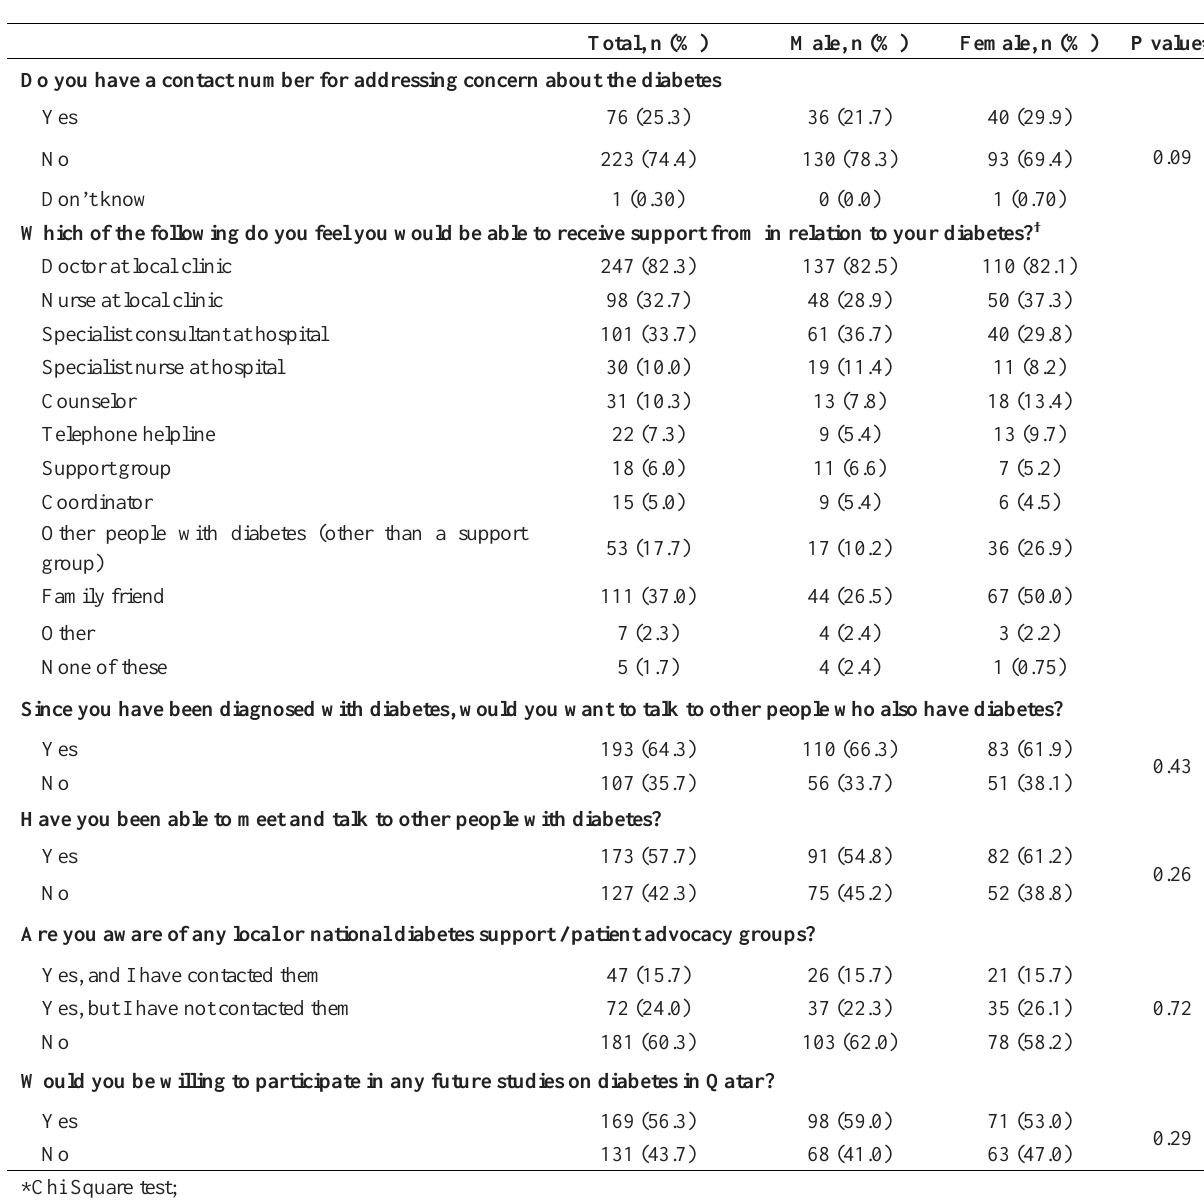
Table 4. Local or Social Support on Diabetes in Qatar response frequency was less than 5) were performed to compare categorical variables by gender. Mann-Whitney test was used to compare duration of diabetes by gender. The threshold level of significance was set at